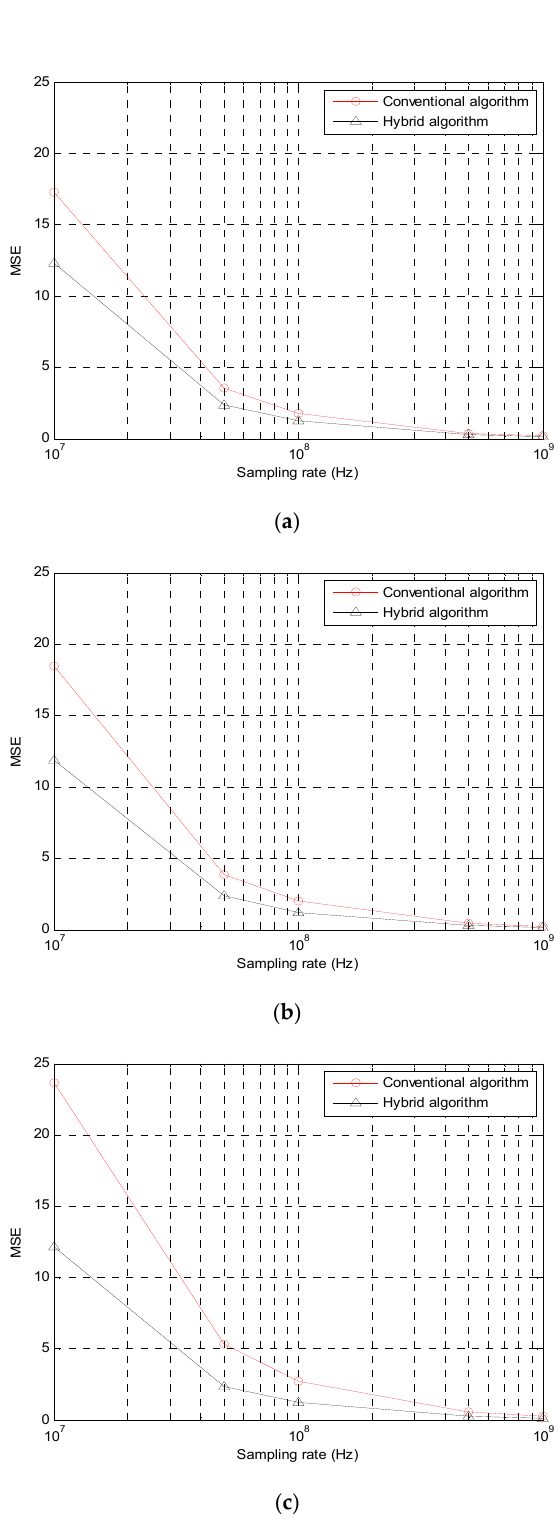
Figure 11. MSE curves for the estimated MS locations based on the proposed hybrid algorithm and the conventional algorithm, of the third scenario for ( a ) the first case, ( b ) the second case, and ( c ) the third case, for the first set.